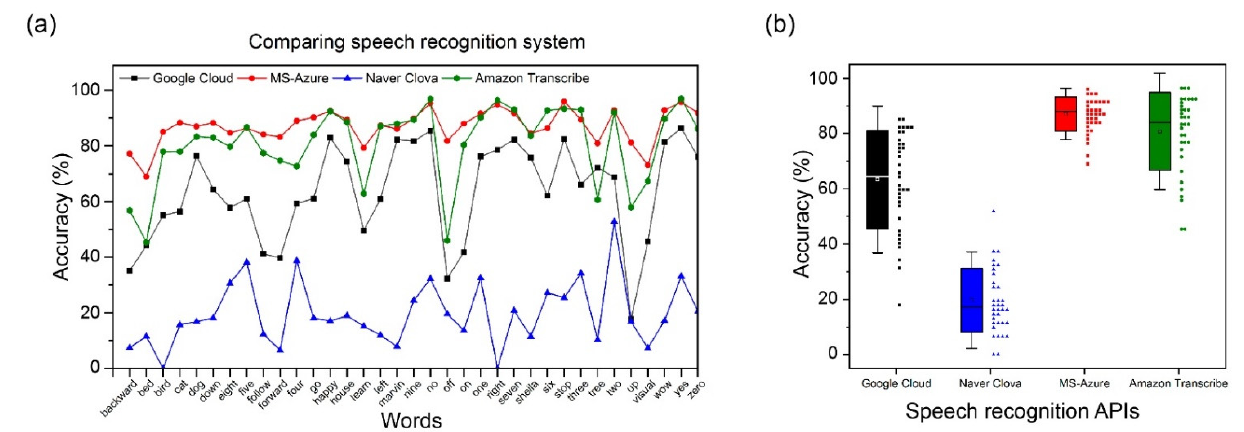
Figure 7. ( a ) Comparison of the performance of speech recognition APIs for 35 individual words in Google dataset V2; ( b ) Comparison of the mean and distribution of speech recognition APIs for Google dataset V2. Error bars represent standard deviation. The squares on the left represent the mean and distribution, and the 35 small structures on the right represent the respective accuracies for 35 words of Google dataset V2.